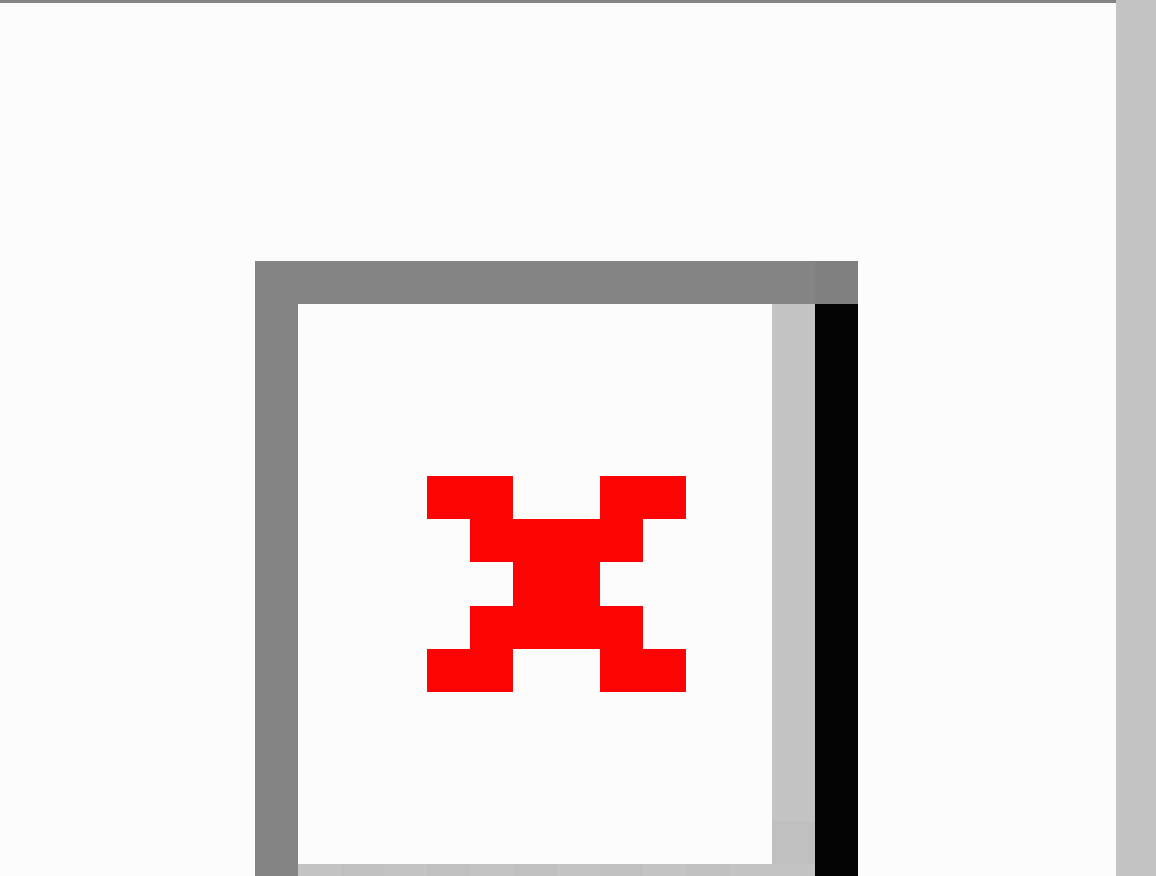
Figure 4. Depiction of sociograms from March 2011 through September 2011 juxtaposed with one another and the sociogram of the traditional